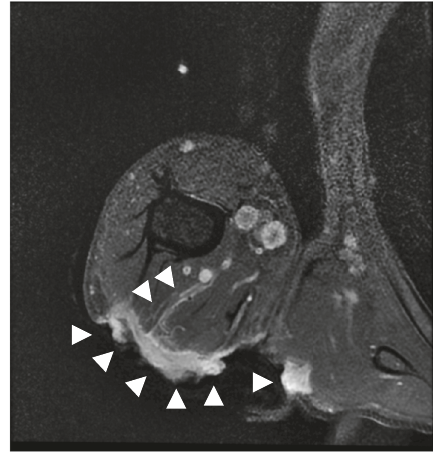
Figure 2: Axial view of the dermatofibroma (arrowhead) on magnetic resonance imaging; invasion to the deltoid and triceps brachii muscles is